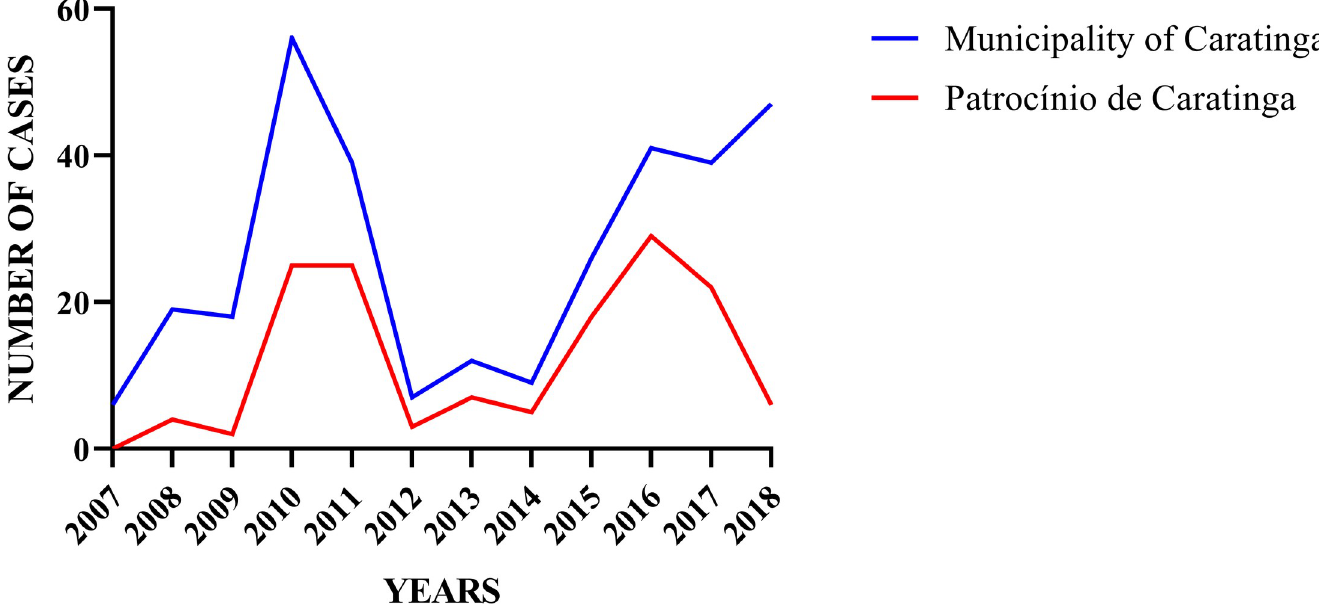
Fig 2. Distribution of ATL cases in the city of Caratinga and in the district of Patrocı´nio de Caratinga.